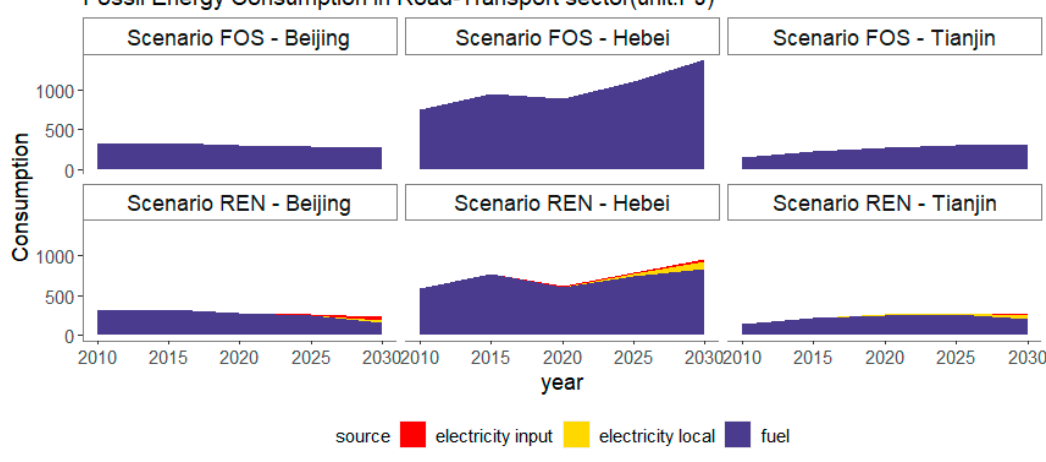
Figure 2. Fossil energy consumption in two scenarios in the BTH region.